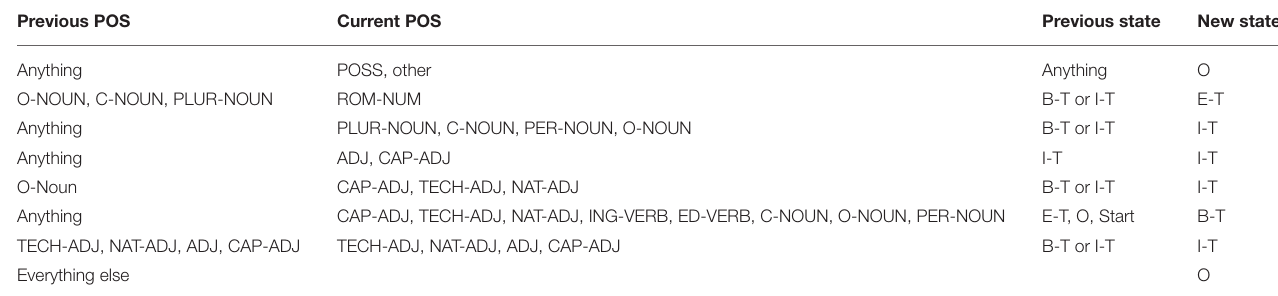
TABLE 1 | State transition table for terminology